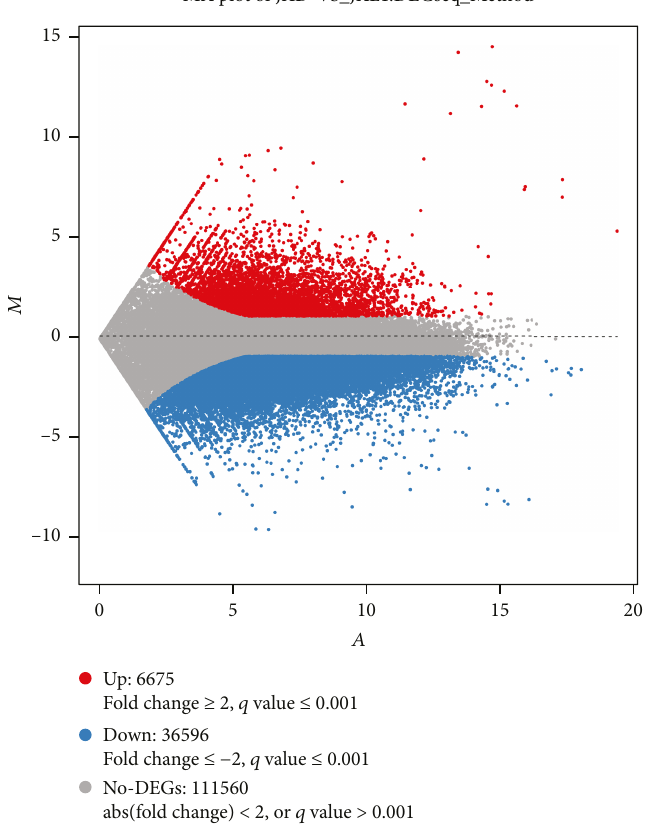
Figure 3: MA plot of DEGs from JXD/JXLT. X -axis represents value A (log2-transformed mean expression level). Y -axis represents value M (log2-transformed fold